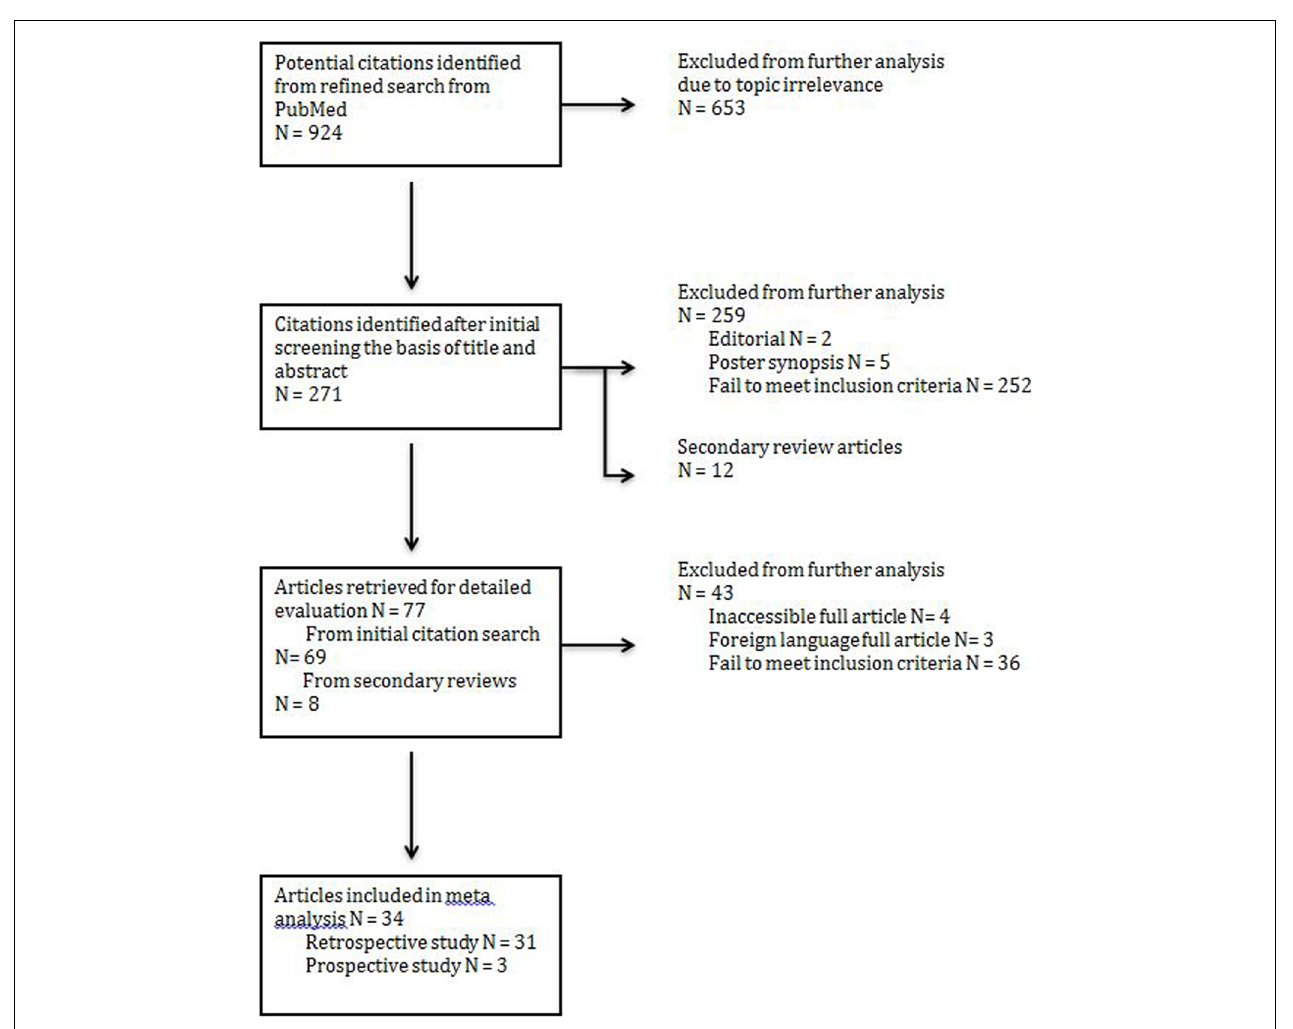
FIGURE 1 | PRISMA (preferred reporting items for systemic reviews and meta-analysis) flow chart illustrating the identification of articles for analysis